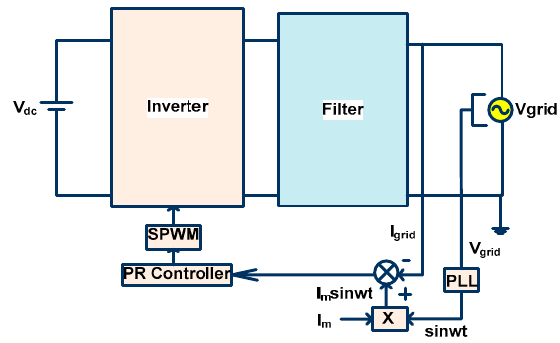
Figure 11. Control strategy block diagram.